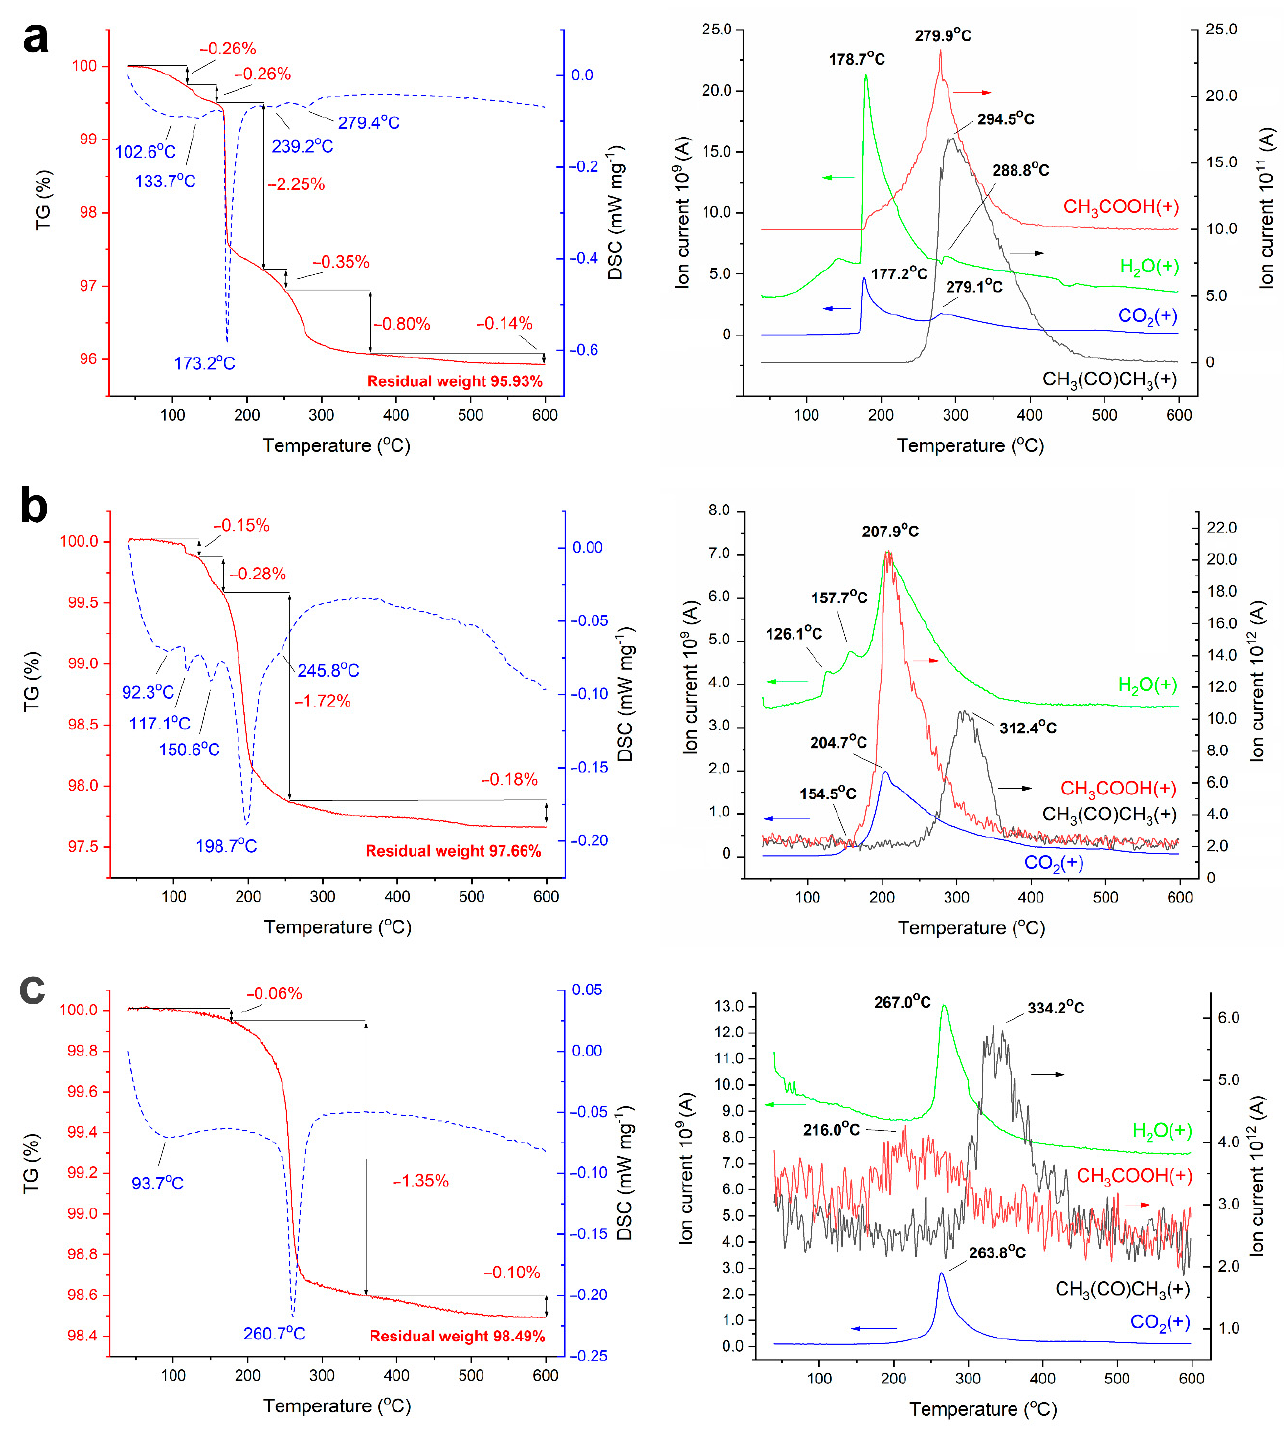
Figure 1. TGA/DSC/MS curves of ZnO@AcZn(5%) ( a ), ZnO@AcZnTVT(5%) ( b ); CSP ZnO@AcZnTVT(5%) ( c ).